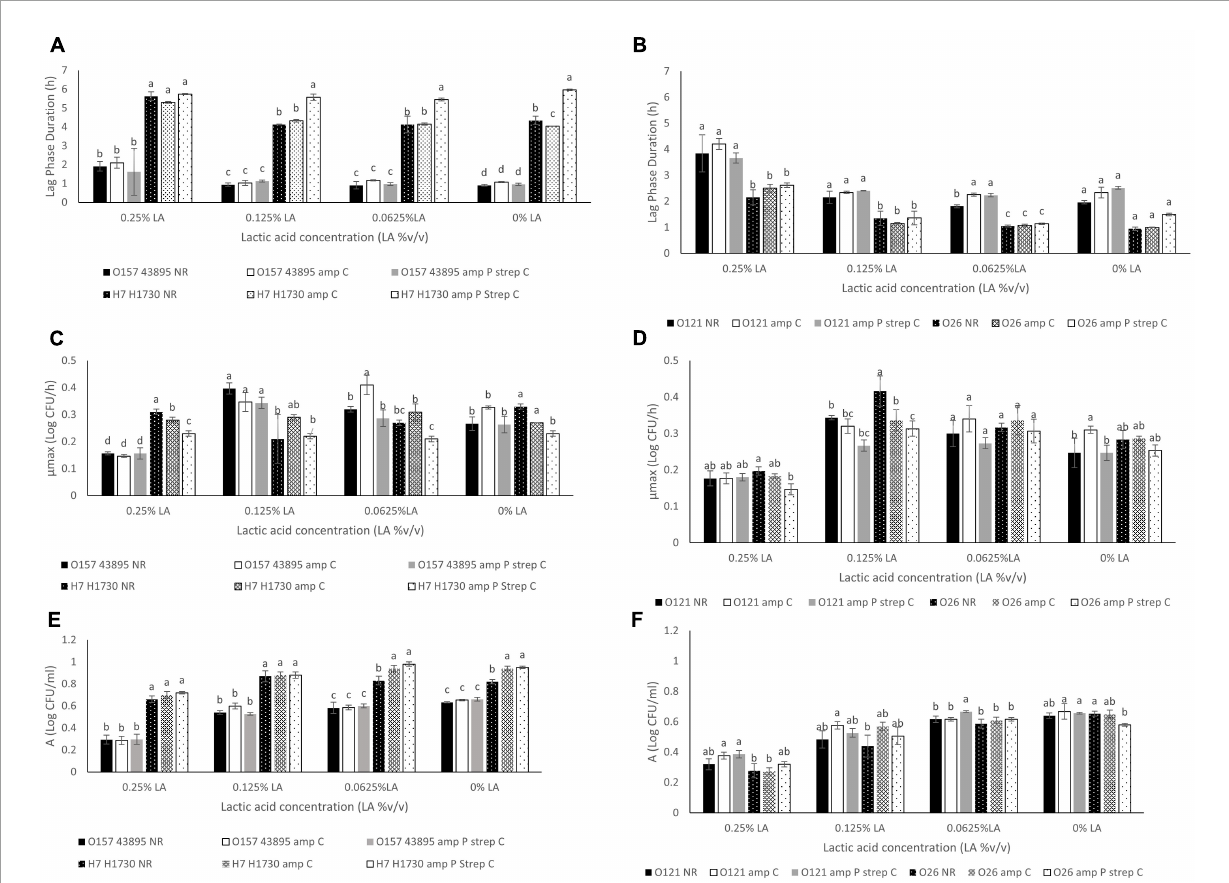
FIGURE2 Comparison of (A) Lag phase duration (L) for O157:H7 STEC- O157 43895 and O157 H1730, (B) . Lag phase duration (L) for non O157:H7 STEC- O121 and O26, (C) . Maximum growth rate ( µ max) for O157:H7 STEC- O157 43895 and O157 H1730, (D) . Maximum growth rate ( µ max) for non O157:H7 STEC- O121 and O26, (E) . Change in bacterial population (A) for O157:H7 STEC- O157 43895 and O157 H1730 (F) . Change in bacterial population (A) for non O157:H7 STEC- O121 and O26. Strains were labeled as NR (no resistance), amp C (chromosomal based resistance to ampicillin) and amp P strep C (plasmid mediated ampicillin resistance and chromosomal streptomycin resistance). Significant differences among strains have been denoted by different